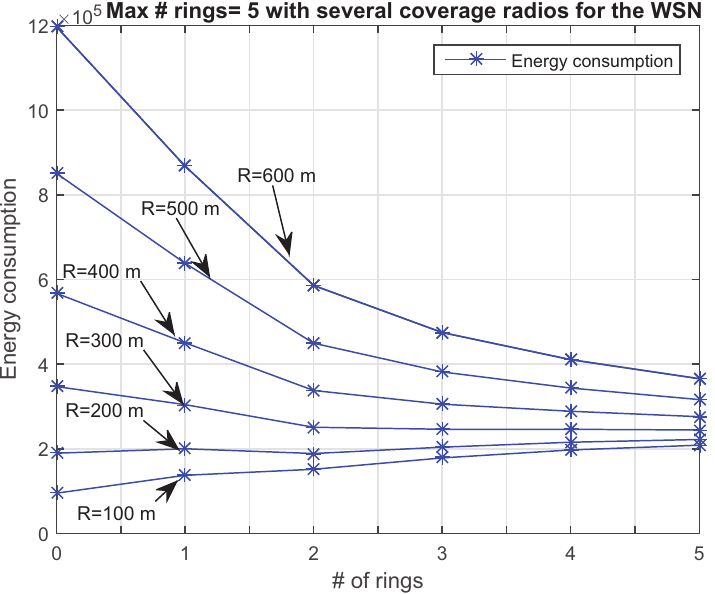
Figure 12. Energy consumption for several radius of the WSN, with N s = 364 sensors, p act = 0.001 and r max =